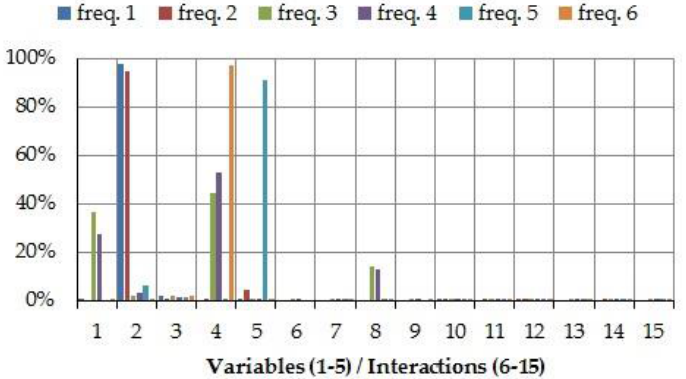
Figure 7. Percentage contribution for natural frequencies in design number 4: 1–5, design variables k X 210 , k Y 3 , k Z 4 , k X 8 , and k Y 9 , respectively; 6–15, two factor interactions k X 21 – k Y 3 , k X 210 – k Z 4 , k X 210 – k X 8 ,